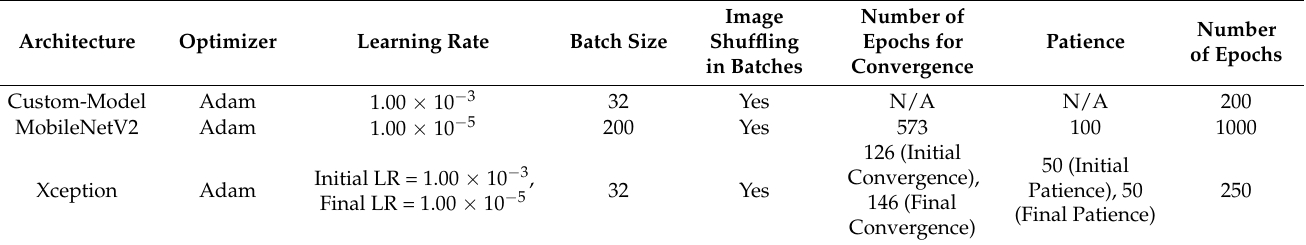
Table 1. Hyperparameter